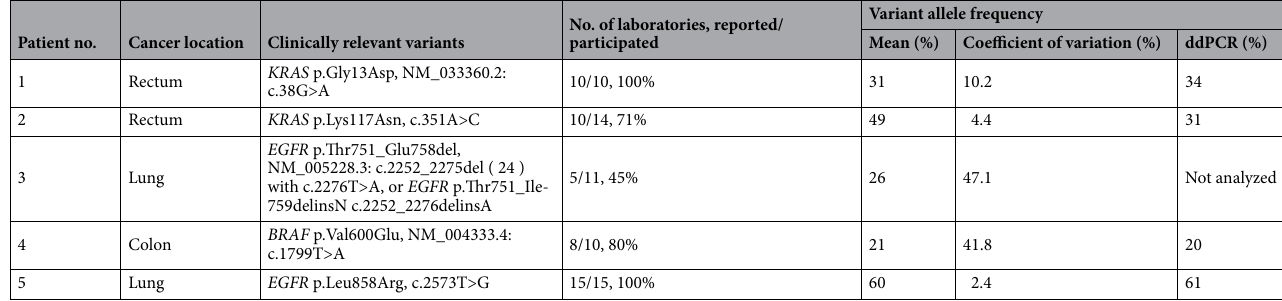
Table 1. Summary of PT results, including successfully reported clinically relevant